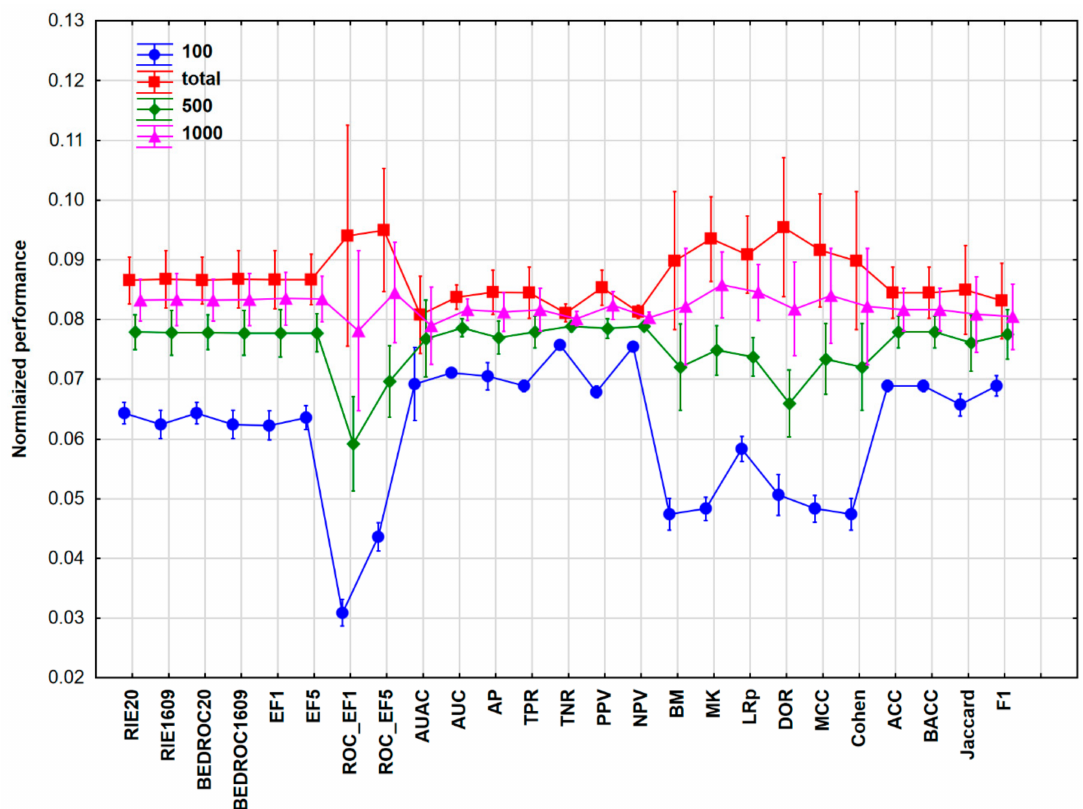
Figure 7. The average normalized values of the different performance parameters with 95% confidence intervals for Case Study 3. Normalization of performance parameters was necessary to be comparable. Number of samples (NS) is 100 (blue circles), 500 (green diamonds), 1000 (pink triangles), or total (1734, red squares).